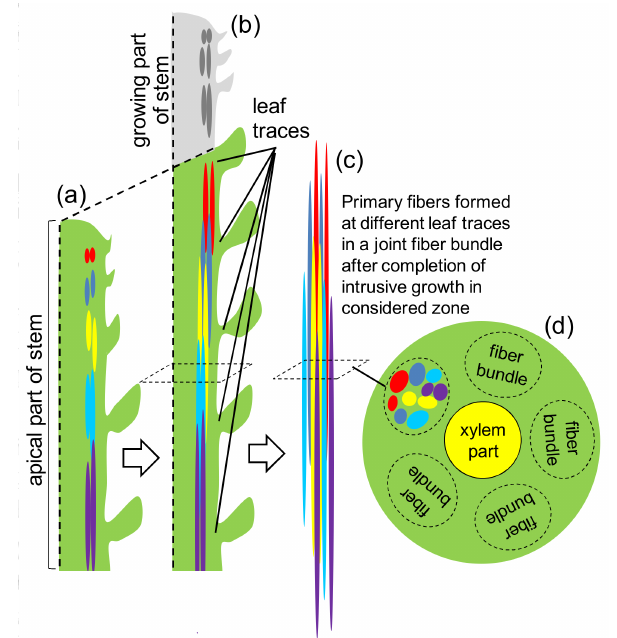
Figure 1. Development of fiber bundles in the course of intrusive elongation of primary bast fibers. ( a ) Scheme of stem radial section (several centimeters from the apex). Fibers originated at different leaf traces are designated by different colors. In the lower internodes of the plant the fibers are more elongated; ( b ) withinseveral days, fibers initiated at different leaf traces elongate by intrusive growth forming a fiber bundle. The additionally grown up stem part is given in grey; ( c ) the enlarged picture of a fiber bundle; and, ( d ) a stem cross-section depicting the formed fiber